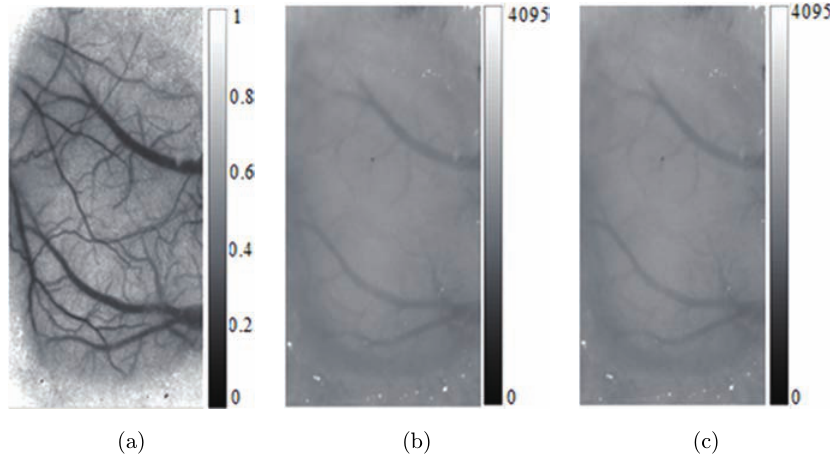
Fig. 3. LSI and OIS images (a) LSI image (b) OIS image at 630 nm (c) OIS image at 870